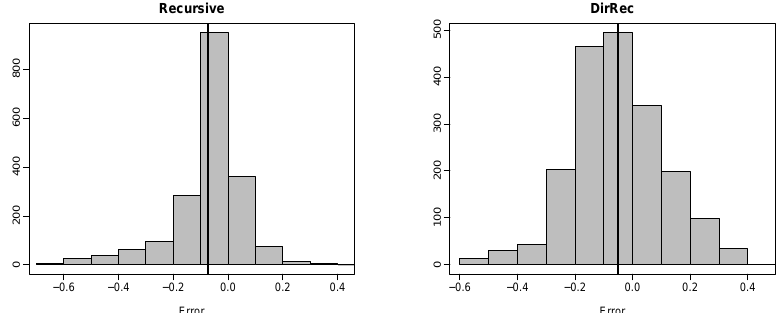
Figure 5. Histograms of pointwise 20-step-ahead forecast errors (black vertical lines denote the mean of the pointwise forecast errors) were obtained by all the methods for the log mortality dataset of Australia (female).